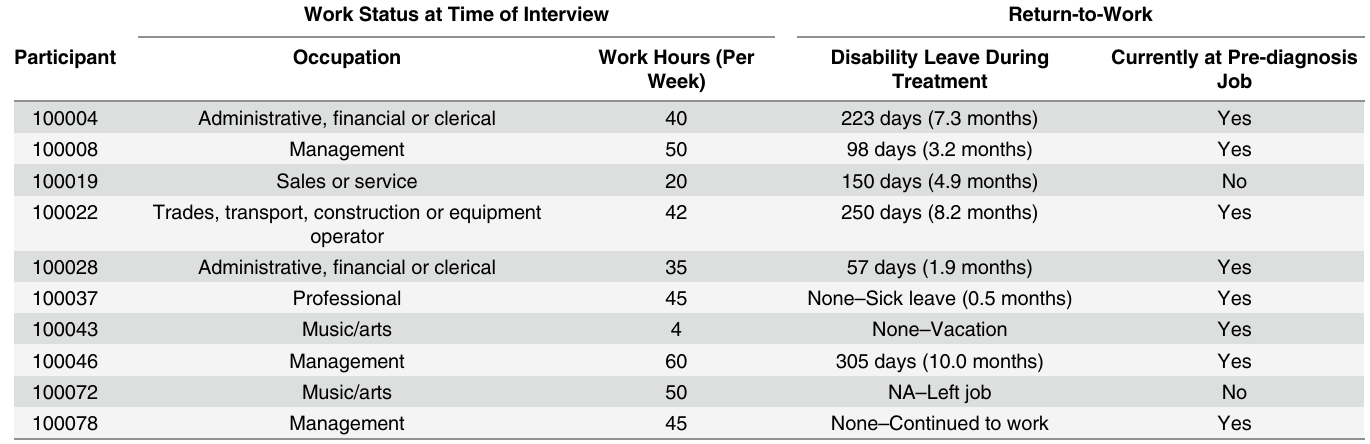
Table 2. Participants ’ Work-related